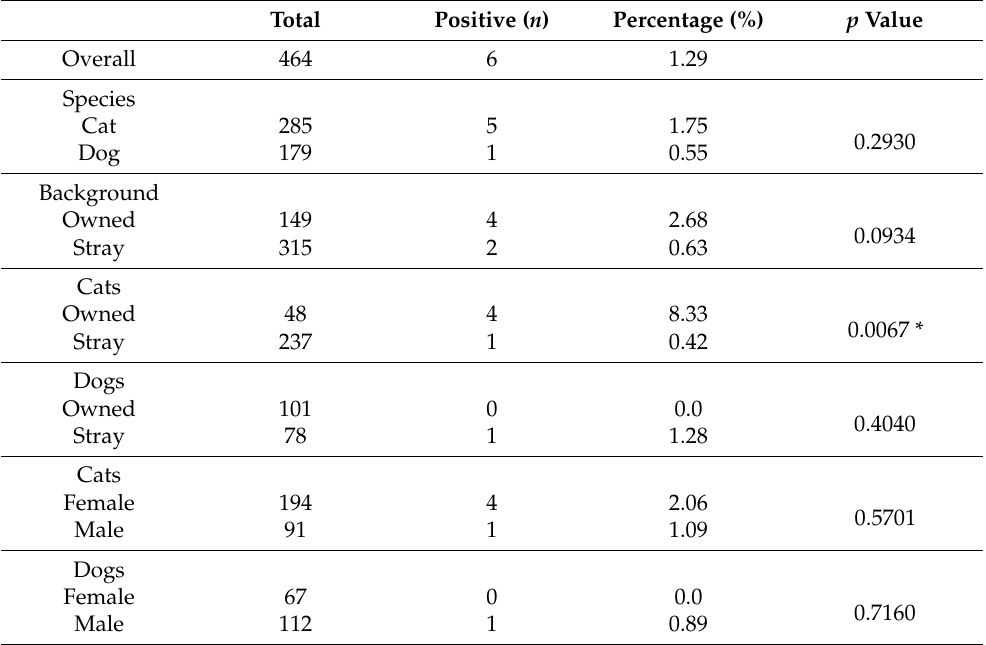
Table 2. Active surveillance SARS-CoV-2 risk